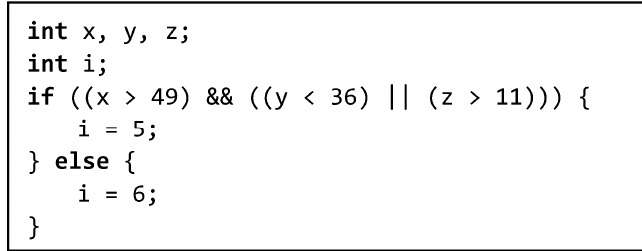
Figure 1. Example program for Hot/Cold path analysis.